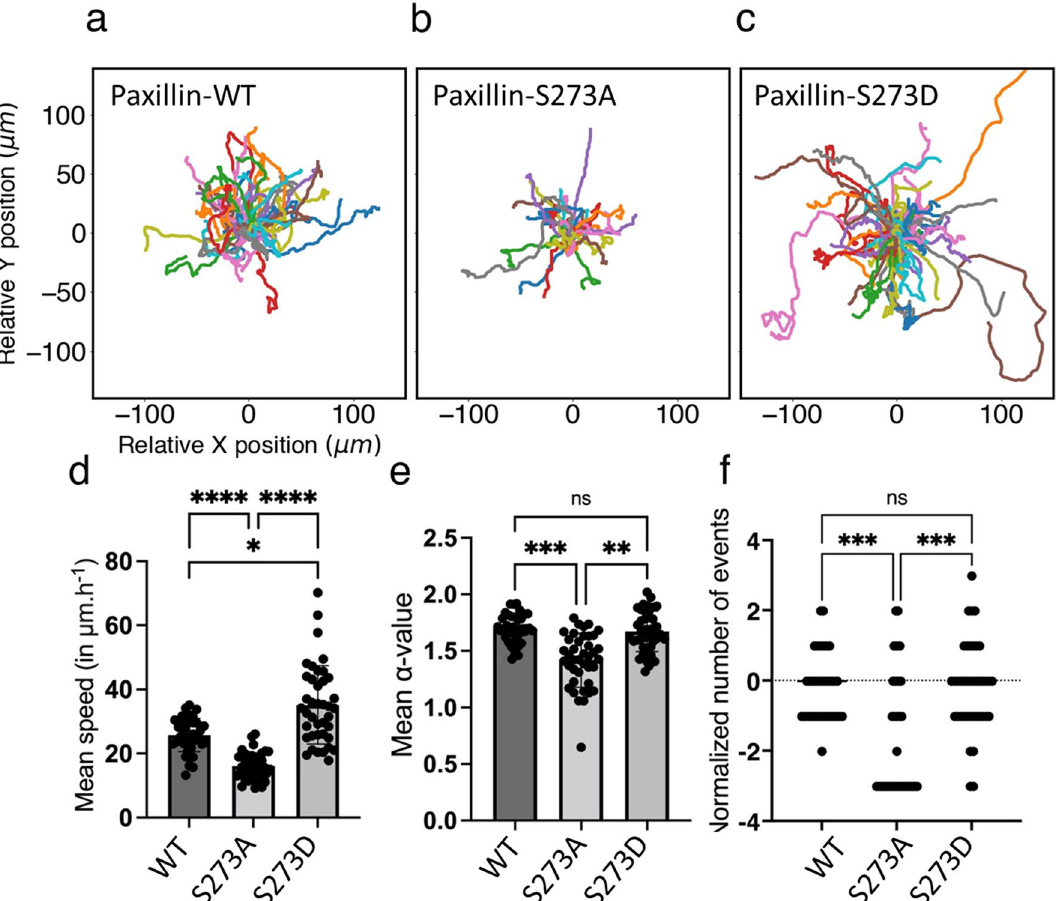
Figure 6. Serine-273 (S273) residue on paxillin is key to CHO-K1 cell migration. Roseplots showing 40 cell tracks for each of CHO-K1 cells expressing paxillin-WT-EGFP, paxillin-S273A-EGFP phosphomutant or paxillin-S273D-EGFP phosphomimic from 2 (paxillin-WT) or 3 experimental replicates (S273D, S273A). Cell tracks of CHO-K1 expressing ( a ) paxillin-WT-EGFP, ( b ) paxillin-S273A-EGFP or ( c ) paxillin-S273D-EGFP. ( d ) Mean instantaneous speed of the same sampled cells in each condition, measured over 360 minute-long recordings. ( e ) Mean α -value of the same sampled cells in each condition, computed using a rolling window of 60 minutes. ( f ) Normalized number of events relative to WT of the same sampled cells in each condition computed over their entire tracks using the normalization formula: (number of events in each condition - average number of events in WT)/standard deviation of the WT distribution of events. Error bars indicate SEM. Cell tracking data from Rajah et al. 40 were used to produce the